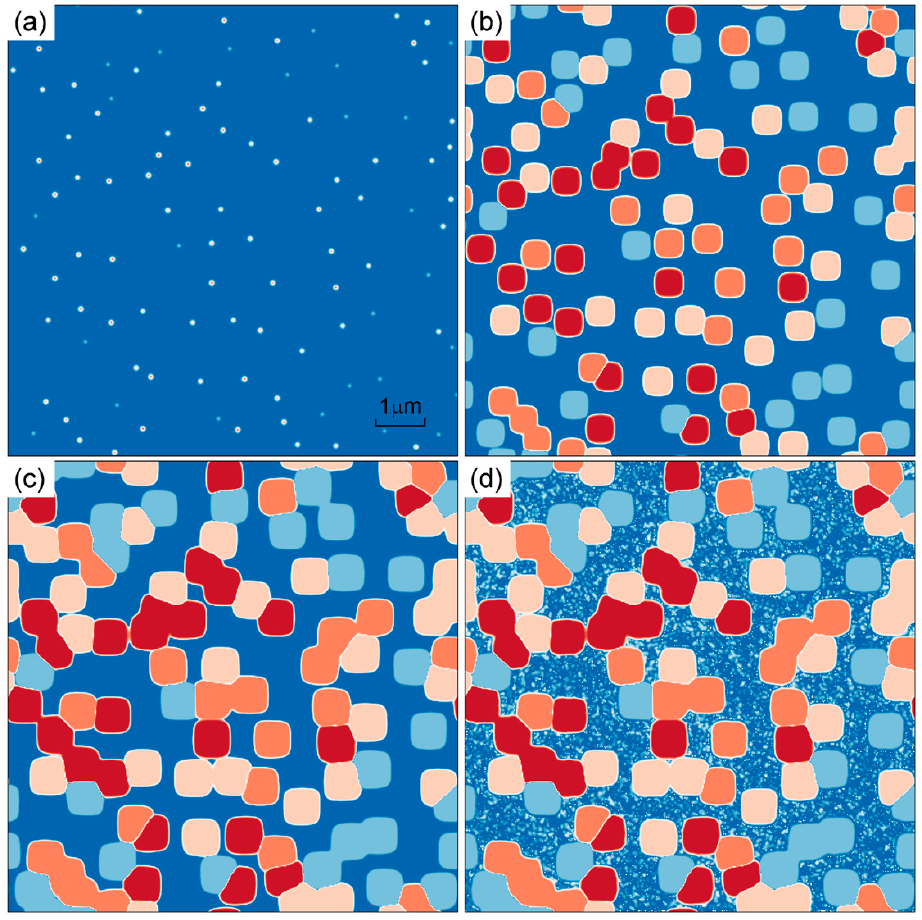
Figure 8. Simulated microstructure evolution at t = 0.012 ( a ), 60 ( b ), 240 ( c ) and 261.9 min ( d ) of DD6 superalloy under 1120 ◦ C / 4 h and Rc = 50 ◦ C / min continuous cooling.